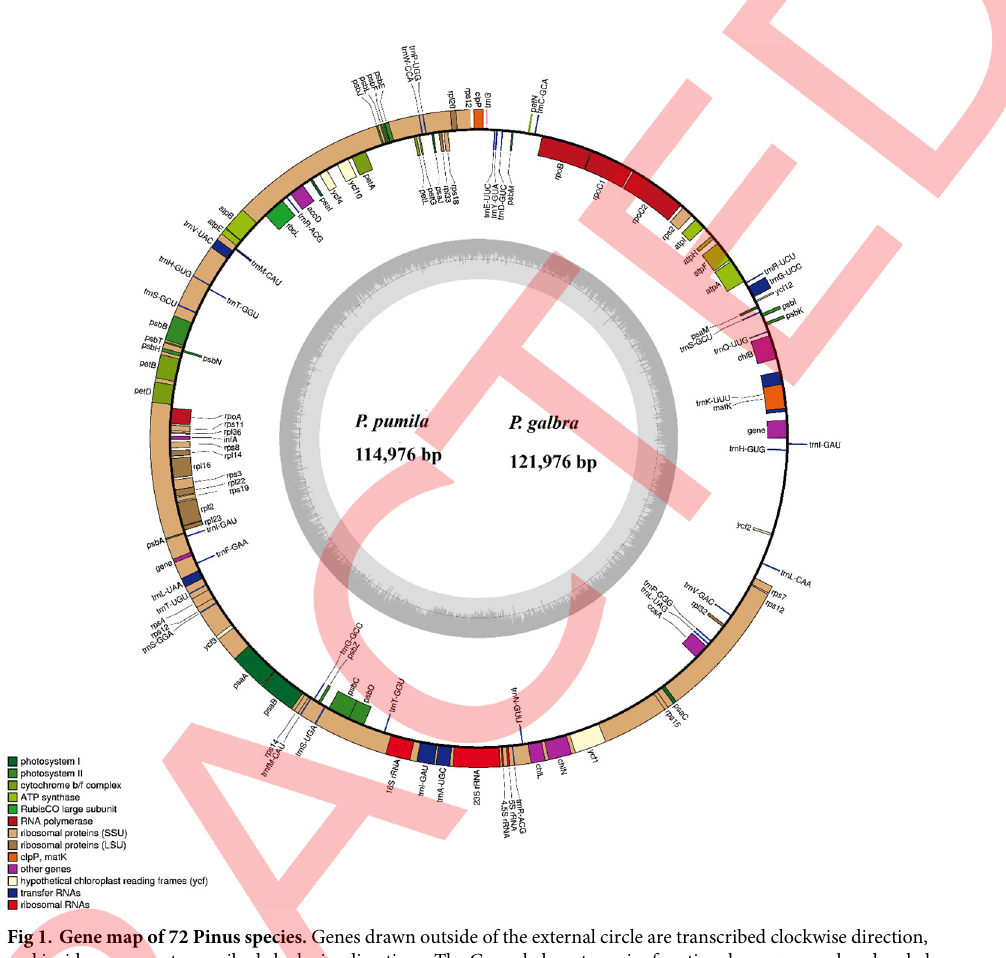
Fig 1. Gene map of 72 Pinus species. Genes drawn outside of the external circle are transcribed clockwise direction, and inside genes are transcribed clockwise directions. The Genes belong to varies functional group are colored coded. The darker gray region inside circle indicates GC content while the lighter gray color to AT content of the cp genome. Large single copy (LSC), small single copy (SSC), inverted repeat (IRs).